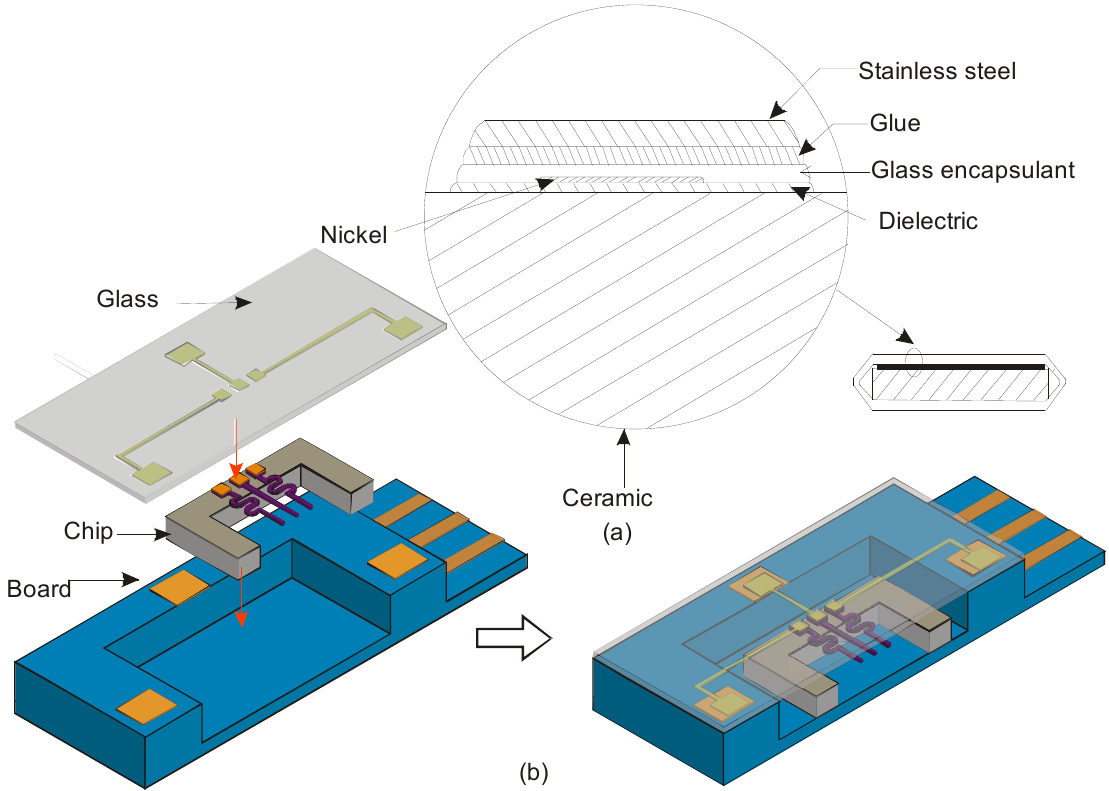
Figure 12. Example of packaging a thermal flow sensor, ( a ) A thermal flow direction element in thick film technology packaged for aggressive media and ( b ) Schematic cross-section of entire assembling of wire sensor developed using SOI technology for harsh aggressive media.